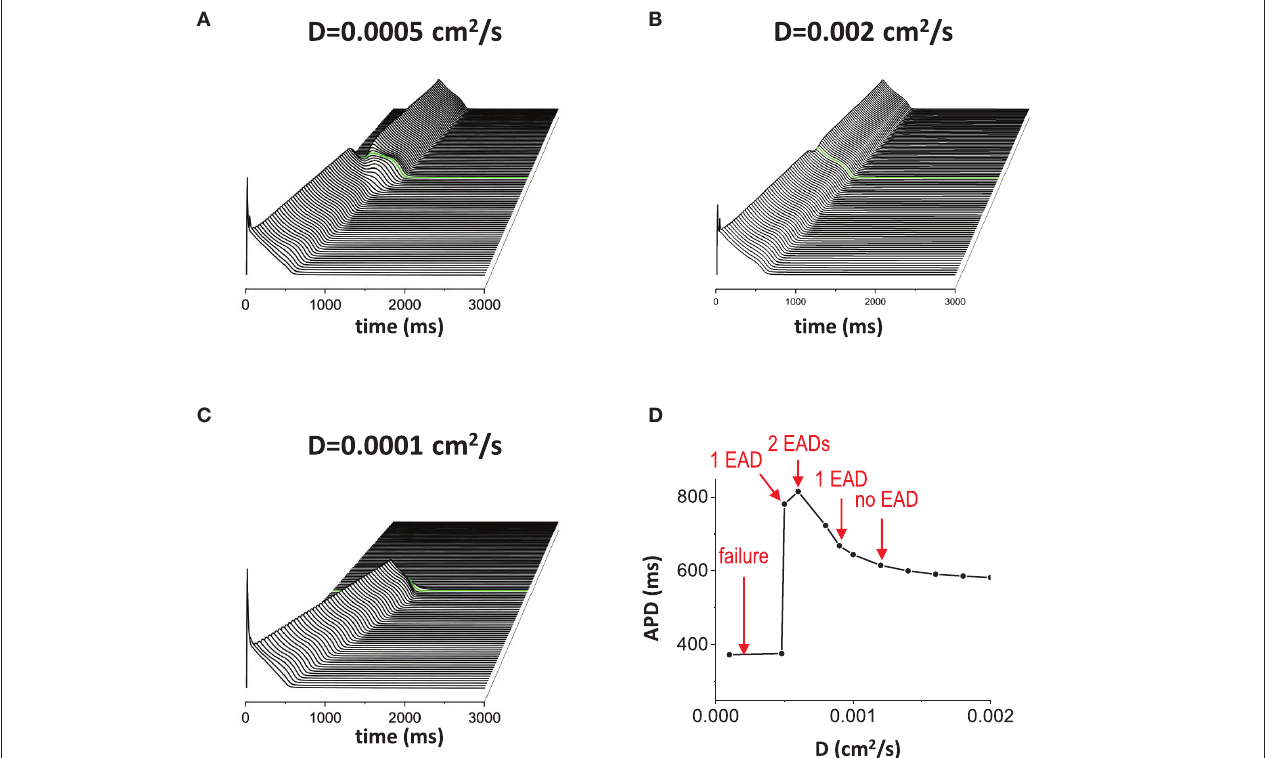
FIGURE 4 | Gap junction conductance affects EAD formation. The diffusive current between cells also affects EAD formation. In this figure, the gap size was fixed at 1.5mm. (A) normal D. D 0.0005 cm 2 /s. (B) large D. D 0.002 cm 2 /s. (C) small D. D 0.00001 cm 2 /s. (D) APD vs. D = = =